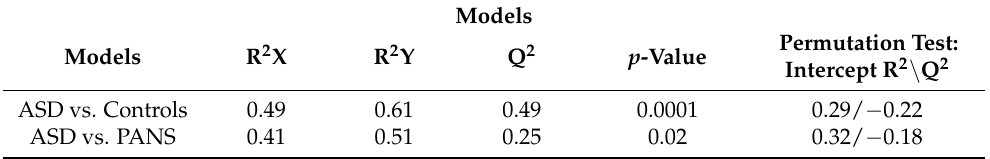
Figure 1. Supervised models of the analysed classes. ( A , B ) ASD (blu circles) vs. control subjects (grey circles) with the respective volcano plot. ( C , D ) PANS (red circles) vs. ASD (blue circles) patients with the respective volcano plot. ASD = autism spectrum disorder; PANS = pediatric acute-onset neuropsychiatric syndrome. Table 2. Statistical parameters of the multivariate models and the respective permutation